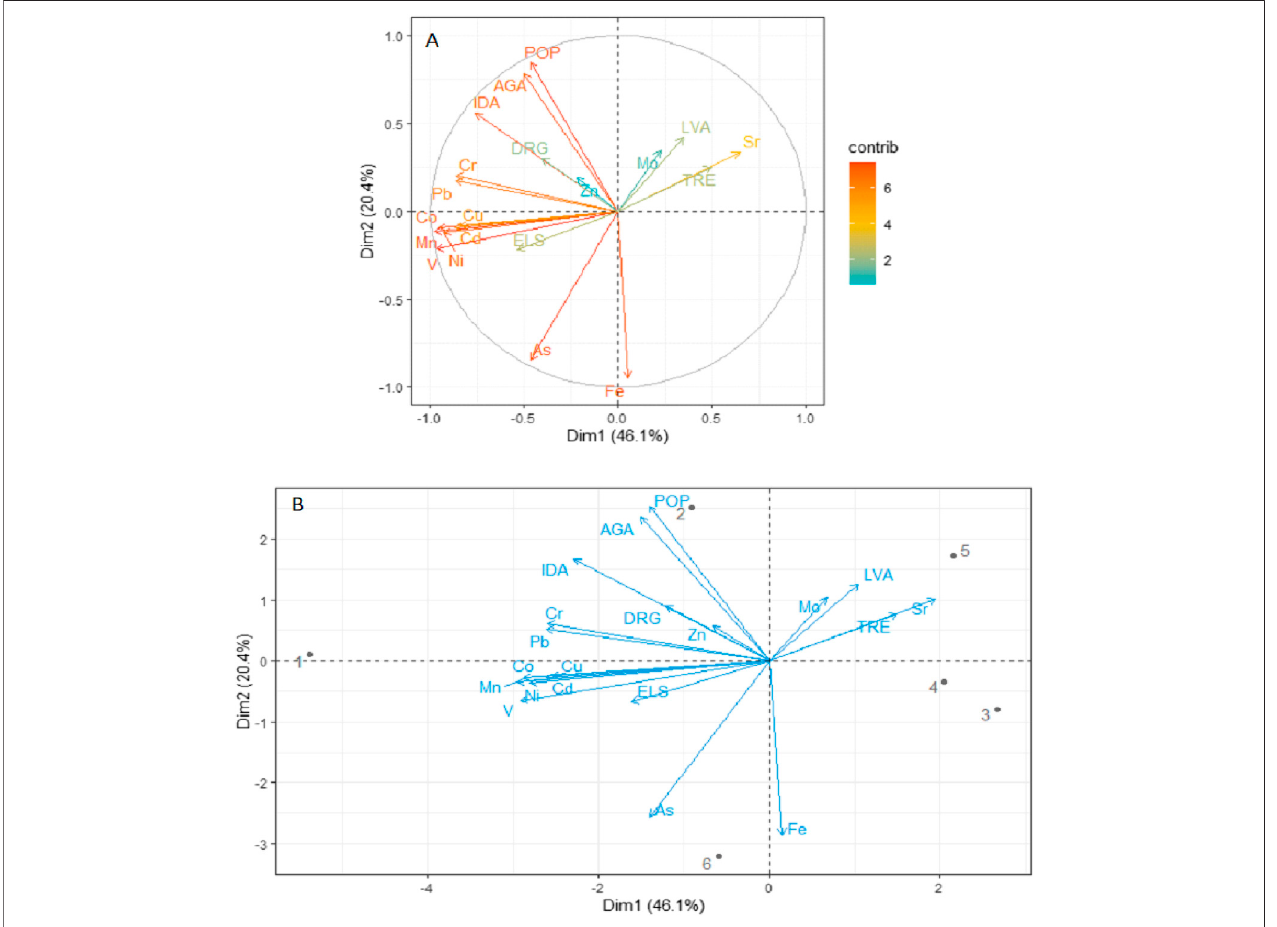
FIGURE 4 | Principal componentanalysis for the relationship between metal concentrations and anthropogenic activities. (A) Contribution todimensions and total variation and (B) biplot. Key: POP, human population; DRG, dredging; ELS, extraction of living resources ( fi shing); TRE, tourism and recreation; LVA, livestock activities; AGA, agricultural activities; IDA, industrialization; 1, Al Lith; 2, south Jeddah; 3, Dahban; 4, Thuwal; 5, Rabigh; 6, Mastorah.